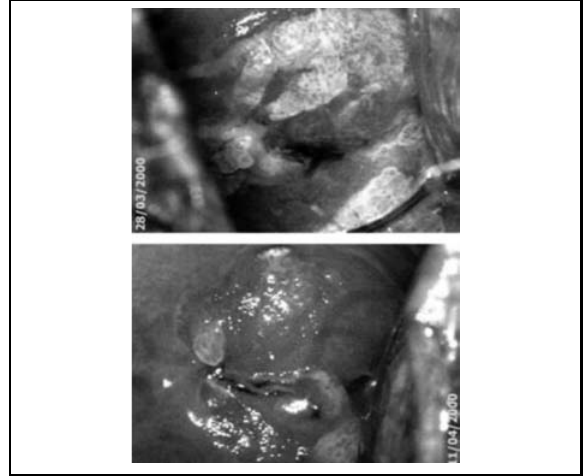
Figura 3 – Imagem colposcópica de condiloma imaturo (caso 2): A: zona de transfor- mação com lesão exofítica papilomatosa extensa em lábio anterior e posterior do colo